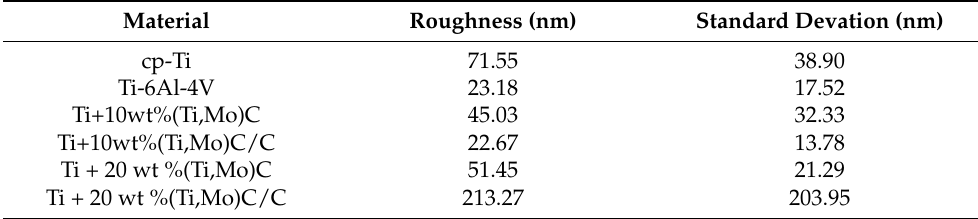
Table 3. The average roughness ( R a ) of the cp-Ti, Ti-6Al-4V alloy and the titanium